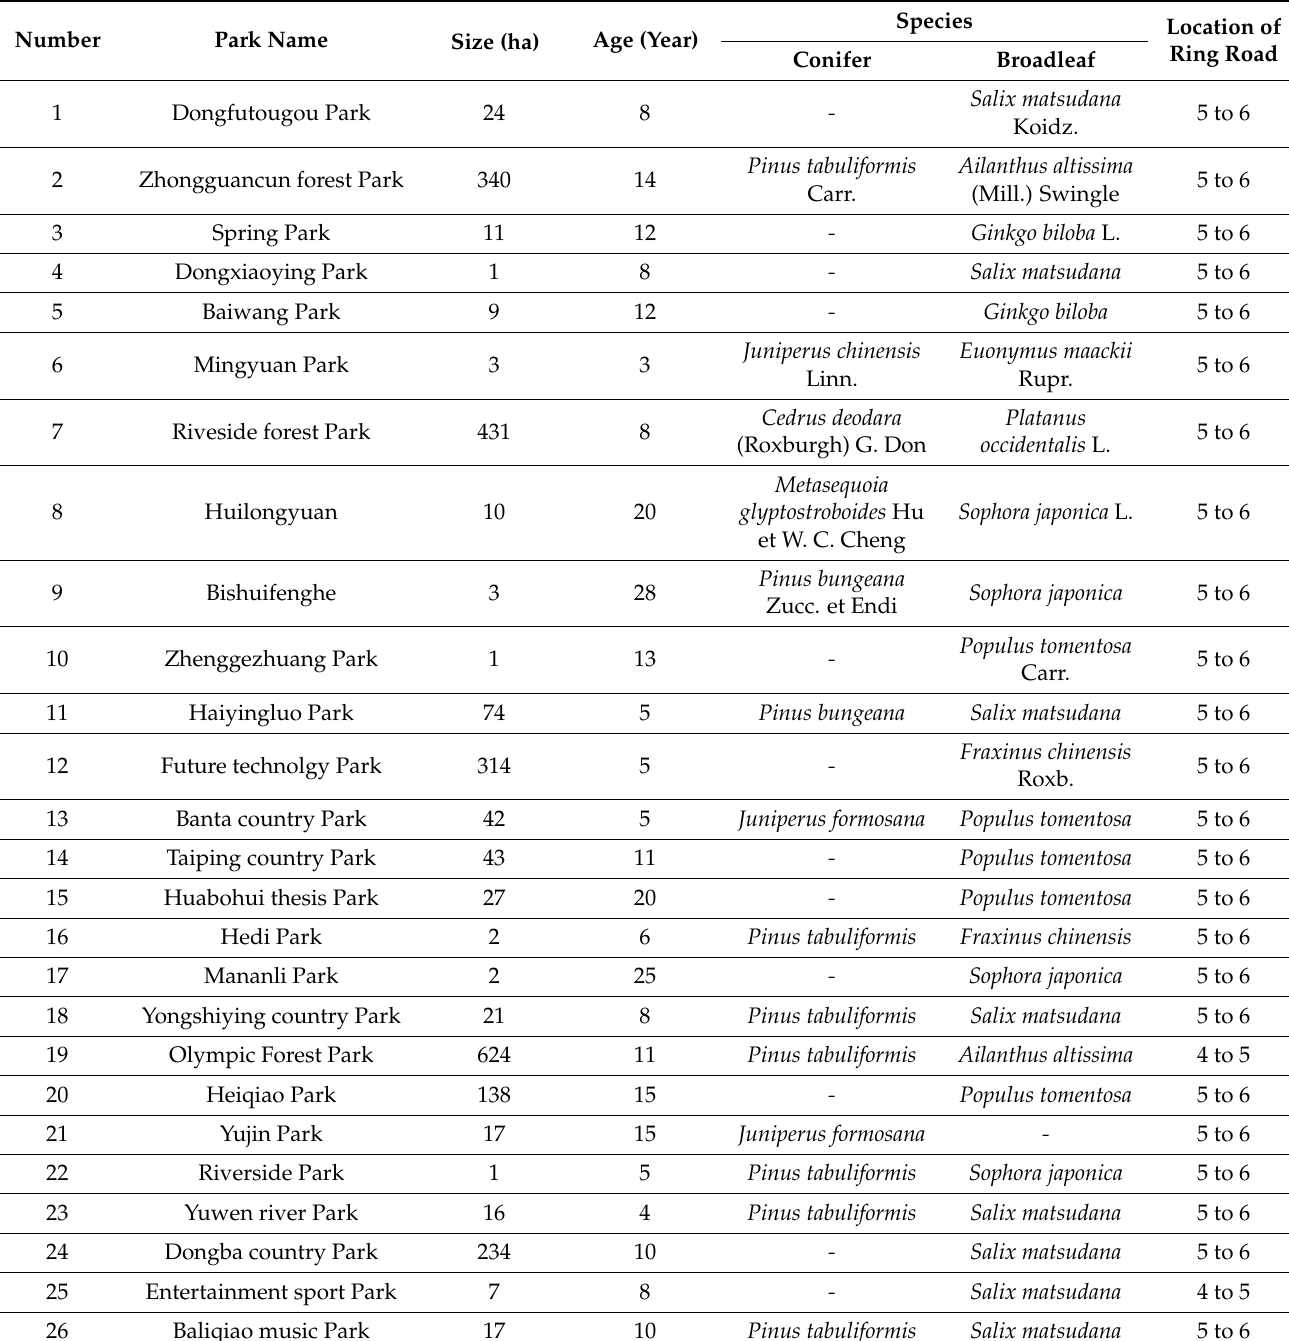
Table A1. List of sampling park names, sizes, ages, tree species, and